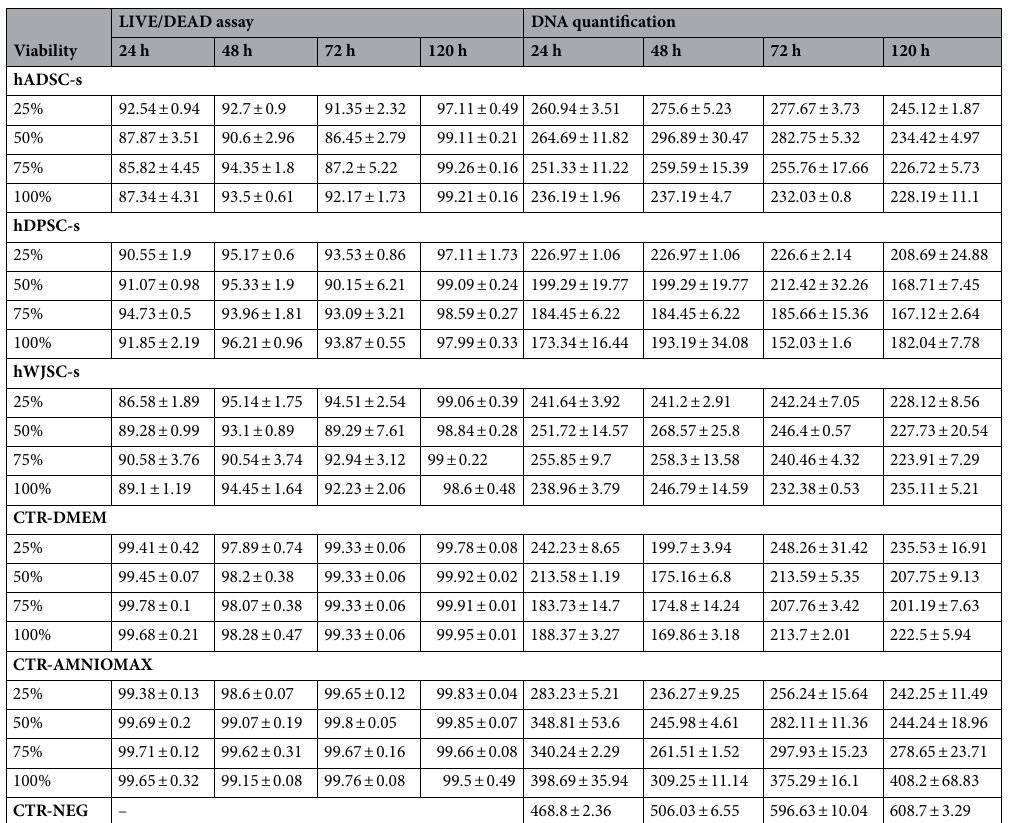
Table 2. Quantitative analysis of cell viability as determined by LIVE/DEAD assay and DNA quantification in HSEC exposed to different types (hADSC-s, hDPSC-s and hWJSC-s) and concentrations (25%, 50%, 75%, 100%) of secretome, or to control (CTR) nonconditioned medium (AMNIOMAX C100 or DMEM) after 24, 48, 72 and 120 h of follow-up. Values are shown as averages ± standard deviations. For the LIVE/DEAD assay, values correspond to percentages of live cells in each group. For DNA quantification, values correspond to the amount of DNA in ng/µL. hADSC-s human adipose-derived MSC secretome, hDPSC-s human dental pulp MSC secretome, hWJSC-s Wharton’s jelly MSC